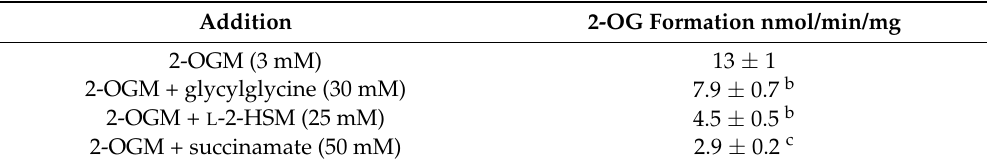
Table 3. Hydrolysis of 2-oxoglutaramate (2-OGM) to 2-oxoglutarate (2-OG) catalyzed by rat liver cytosol in the absence or presence of an inhibitor a . Addition